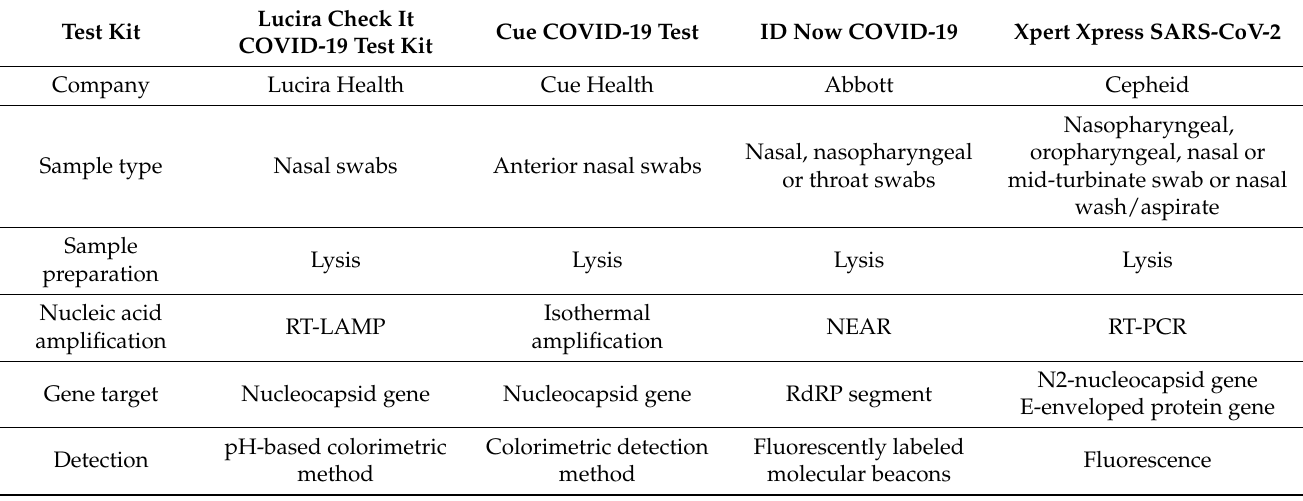
Table 4. Test kits available for nucleic acid amplification-based detection of